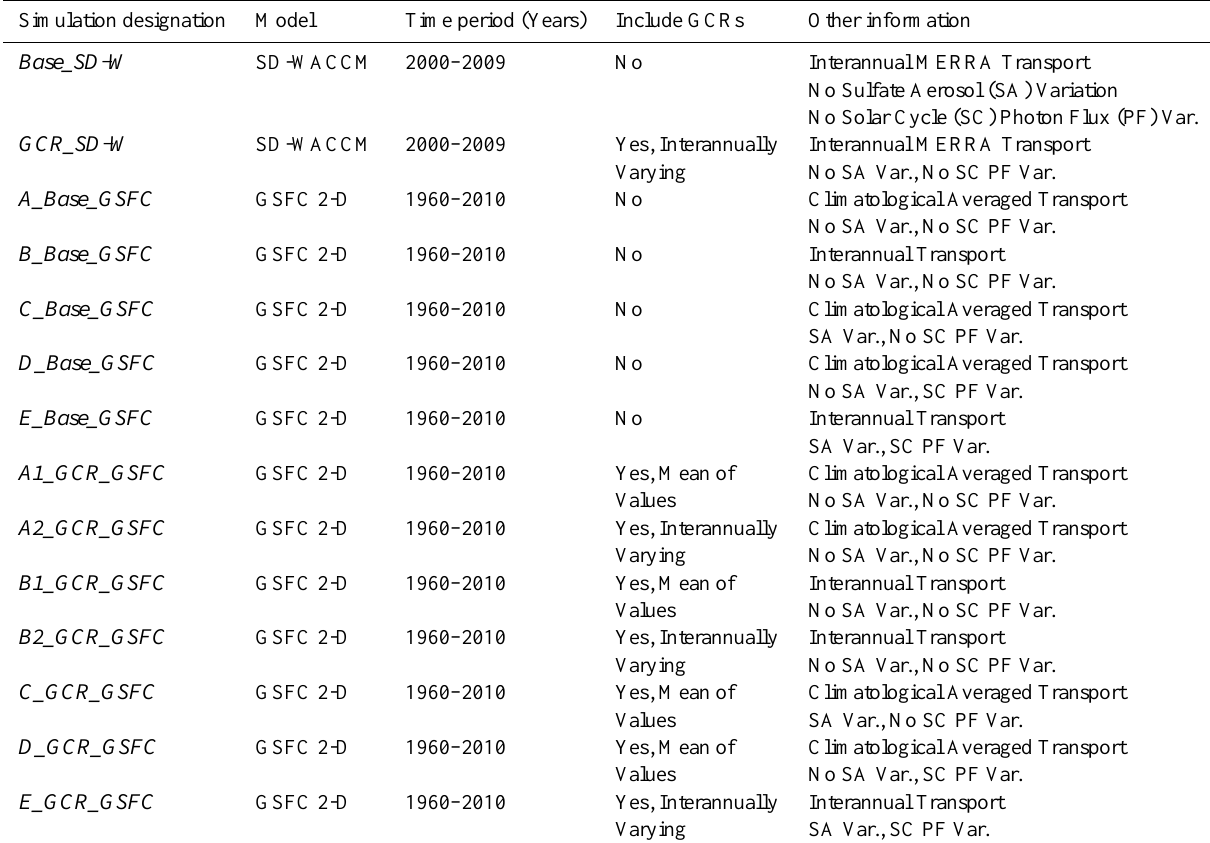
Table 1. Description of model